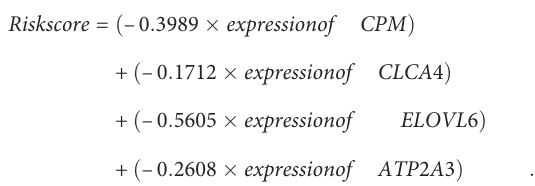
was worse compared to the low-risk group (P< 0.0001; Figure 5C). The area under the ROC curve (AUC) value for 5- year was 0.700; for three year was 0.647, and for one year was